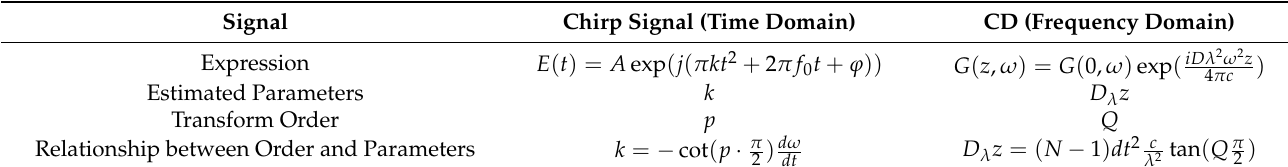
Table 2. Comparison between the chirp signal in the time domain and CD.